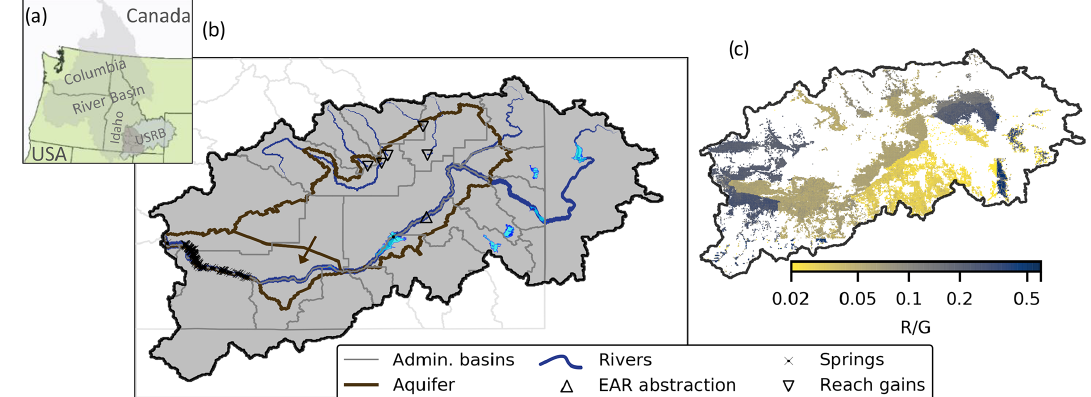
Figure 1. Location of the upper Snake River basin (USRB), a headwater of the Columbia River, in the states of Idaho and Wyoming, USA (a) . Configuration of the major hydrologic features of the USRB, including the two compartments conceptualized for the eastern Snake Plain aquifer (ESPA), the locations of the reach gains where the losing rivers drain to the ESPA, the location of the simulated abstractions for enhanced aquifer recharge (EAR), springs where flow from the ESPA drains back to the upper Snake River, the river network scaled by mean annual flow, and the extent of the administrative basins (IDWR, 2015), indicating areas using common surface water sources for irrigation (b) . Average fraction of gross irrigation comprised of incidental returns (irrigation reuse – R ) (c)